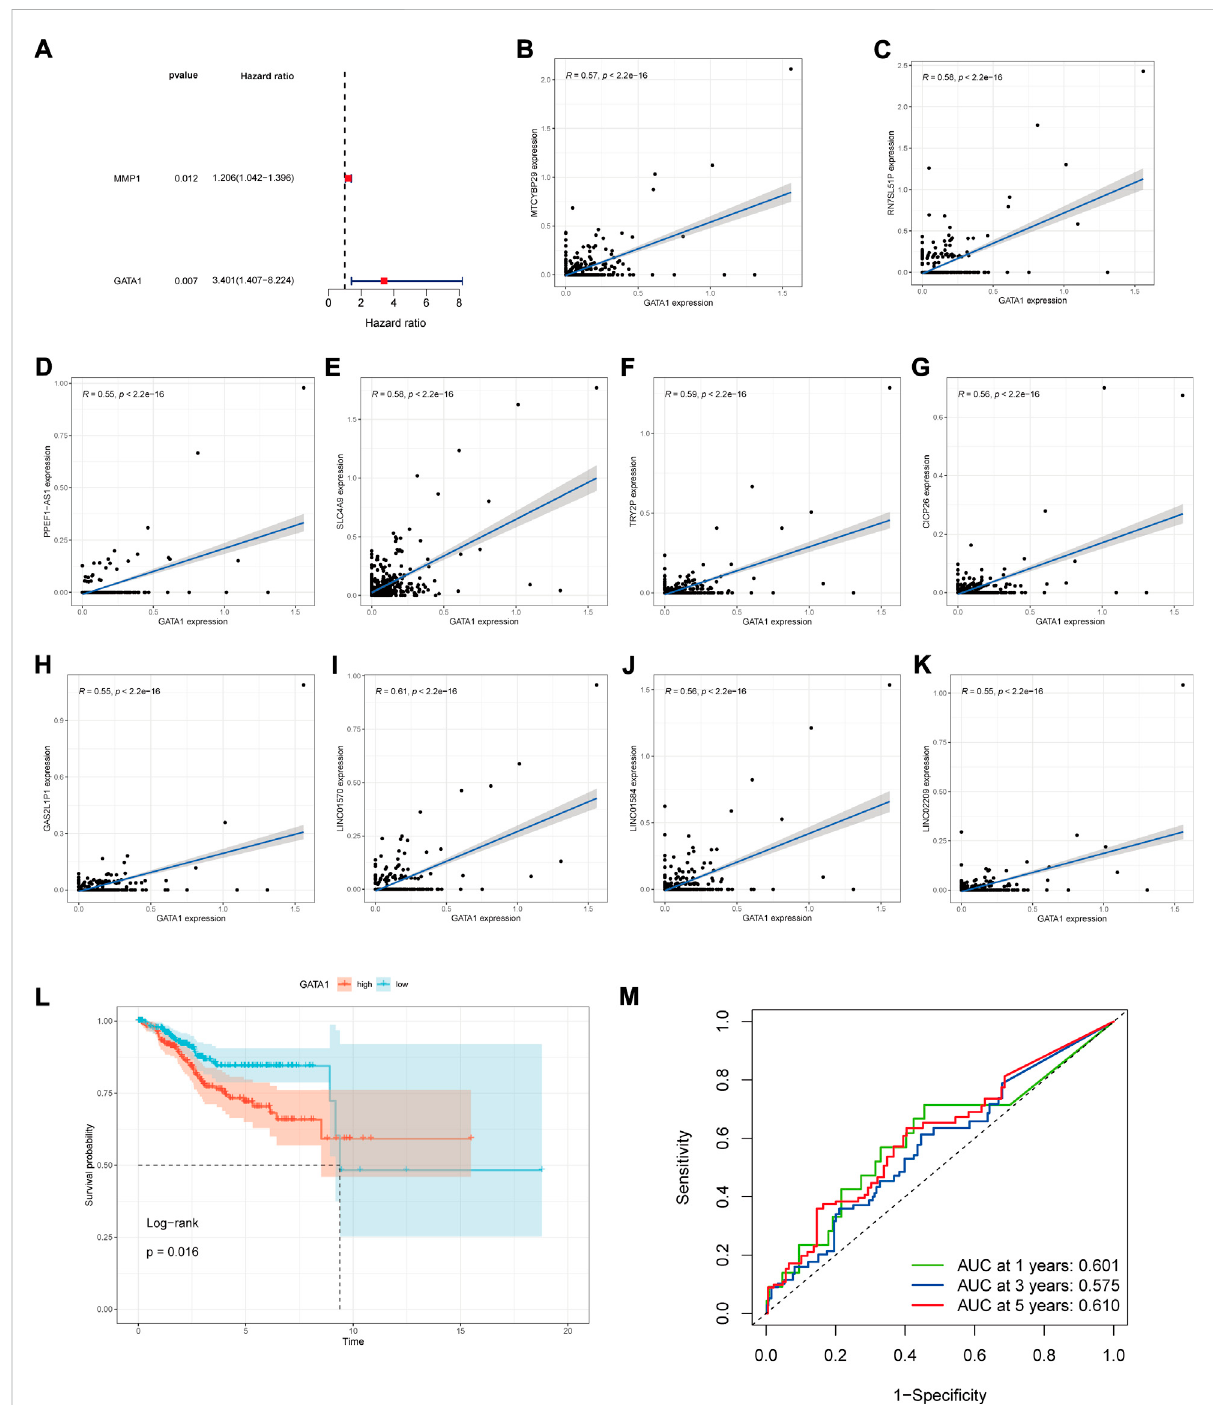
FIGURE 3 GATA1 prognosis and gene correlation analysis. (A) Forestplotsof DR-DEGs associated with UCEC prognosis were obtained by univariate COX regression analysis; (B – K) GATA1 correlation with MTCYBP29, RN7SL51P, PPEF1-AS1, SLC4A9, TRY2P, CICP26, GAS2L1P1, LINC01570, LINC01584, LINC02209correlation analysis; (L) Kaplan-Meier analysisplotof prognostic correlationbetweenhighand low GATA1 expression groups; (M) Time- dependent ROC